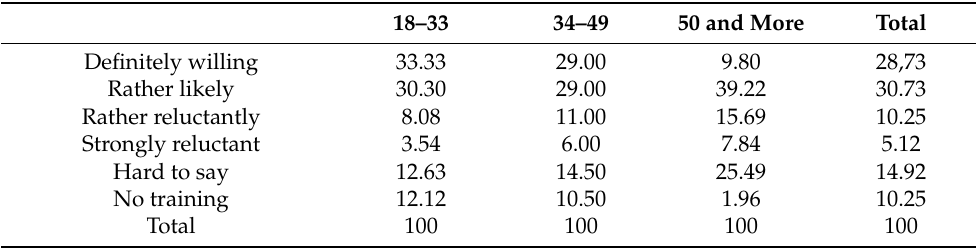
Table 7. Attitude towards participation in training vs. age in % (N = 449).